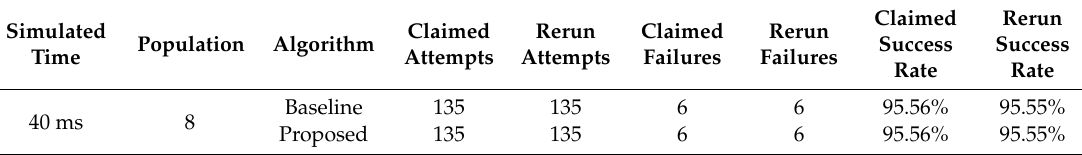
Table 7. Inconsistencies in results.